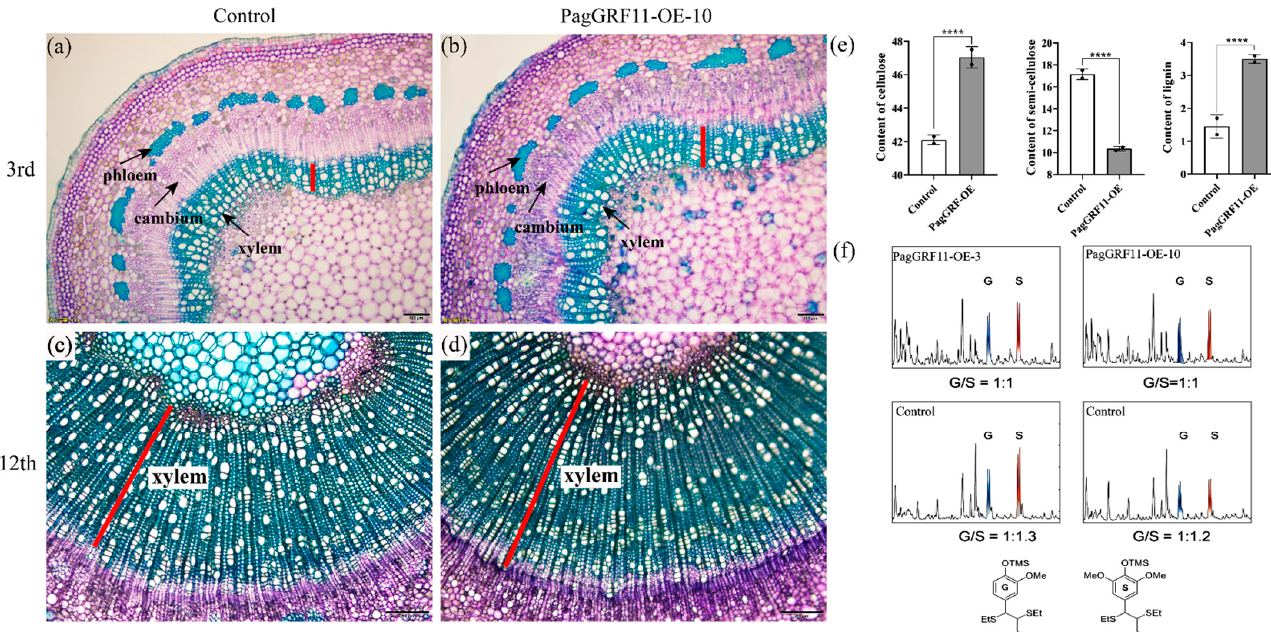
Figure 3. Cross-sections of stems at the 3rd and 12th internode of PagGRF11 and control plants. ( a , b ) Cross section of stem 3rd internode of PagGRF11 and control plants; ( c , d ) Stem 12th internode cross section of PagGRF11 and control plants; ( e ) Analysis of the stem composition of transgenic and control plants; **** denotes p < 0.0001. ( f ) Thiolysis analysis of lignin monomers in 3-month-old PagGRF11-OE and control plants. G: G-type lignin monomer, S: S-type lignin